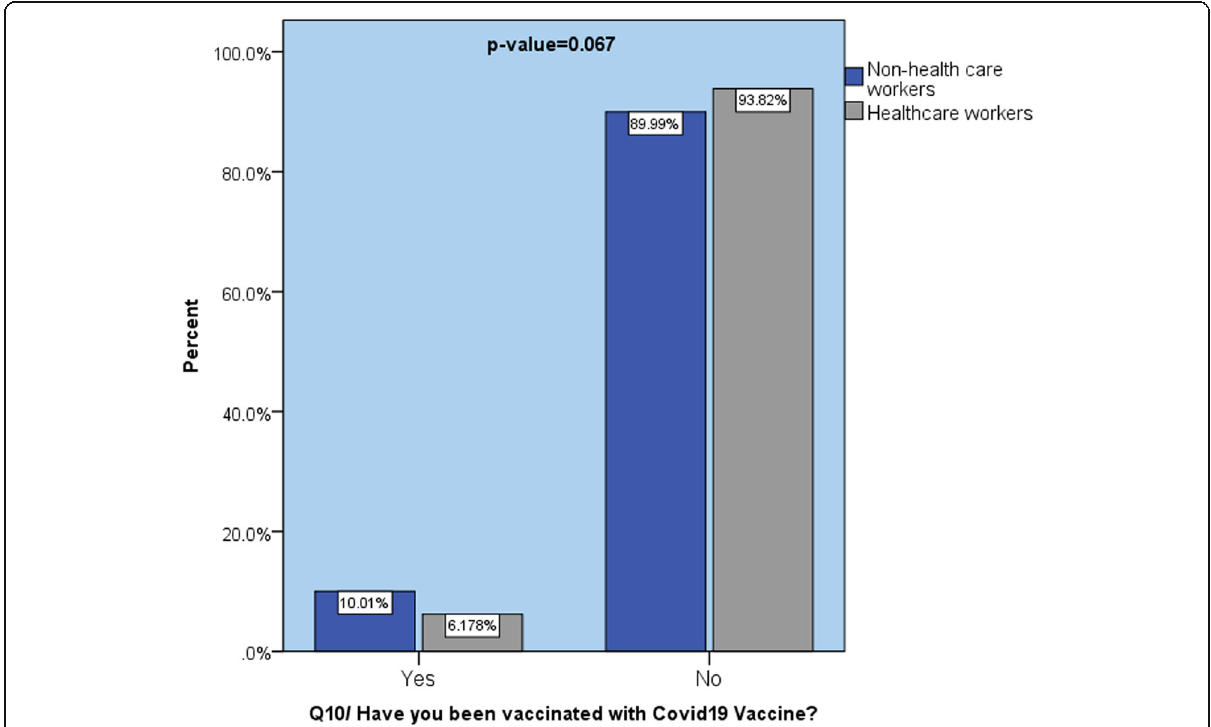
Fig. 1 Comparison of COVID-19 vaccination among healthcare and non-healthcare